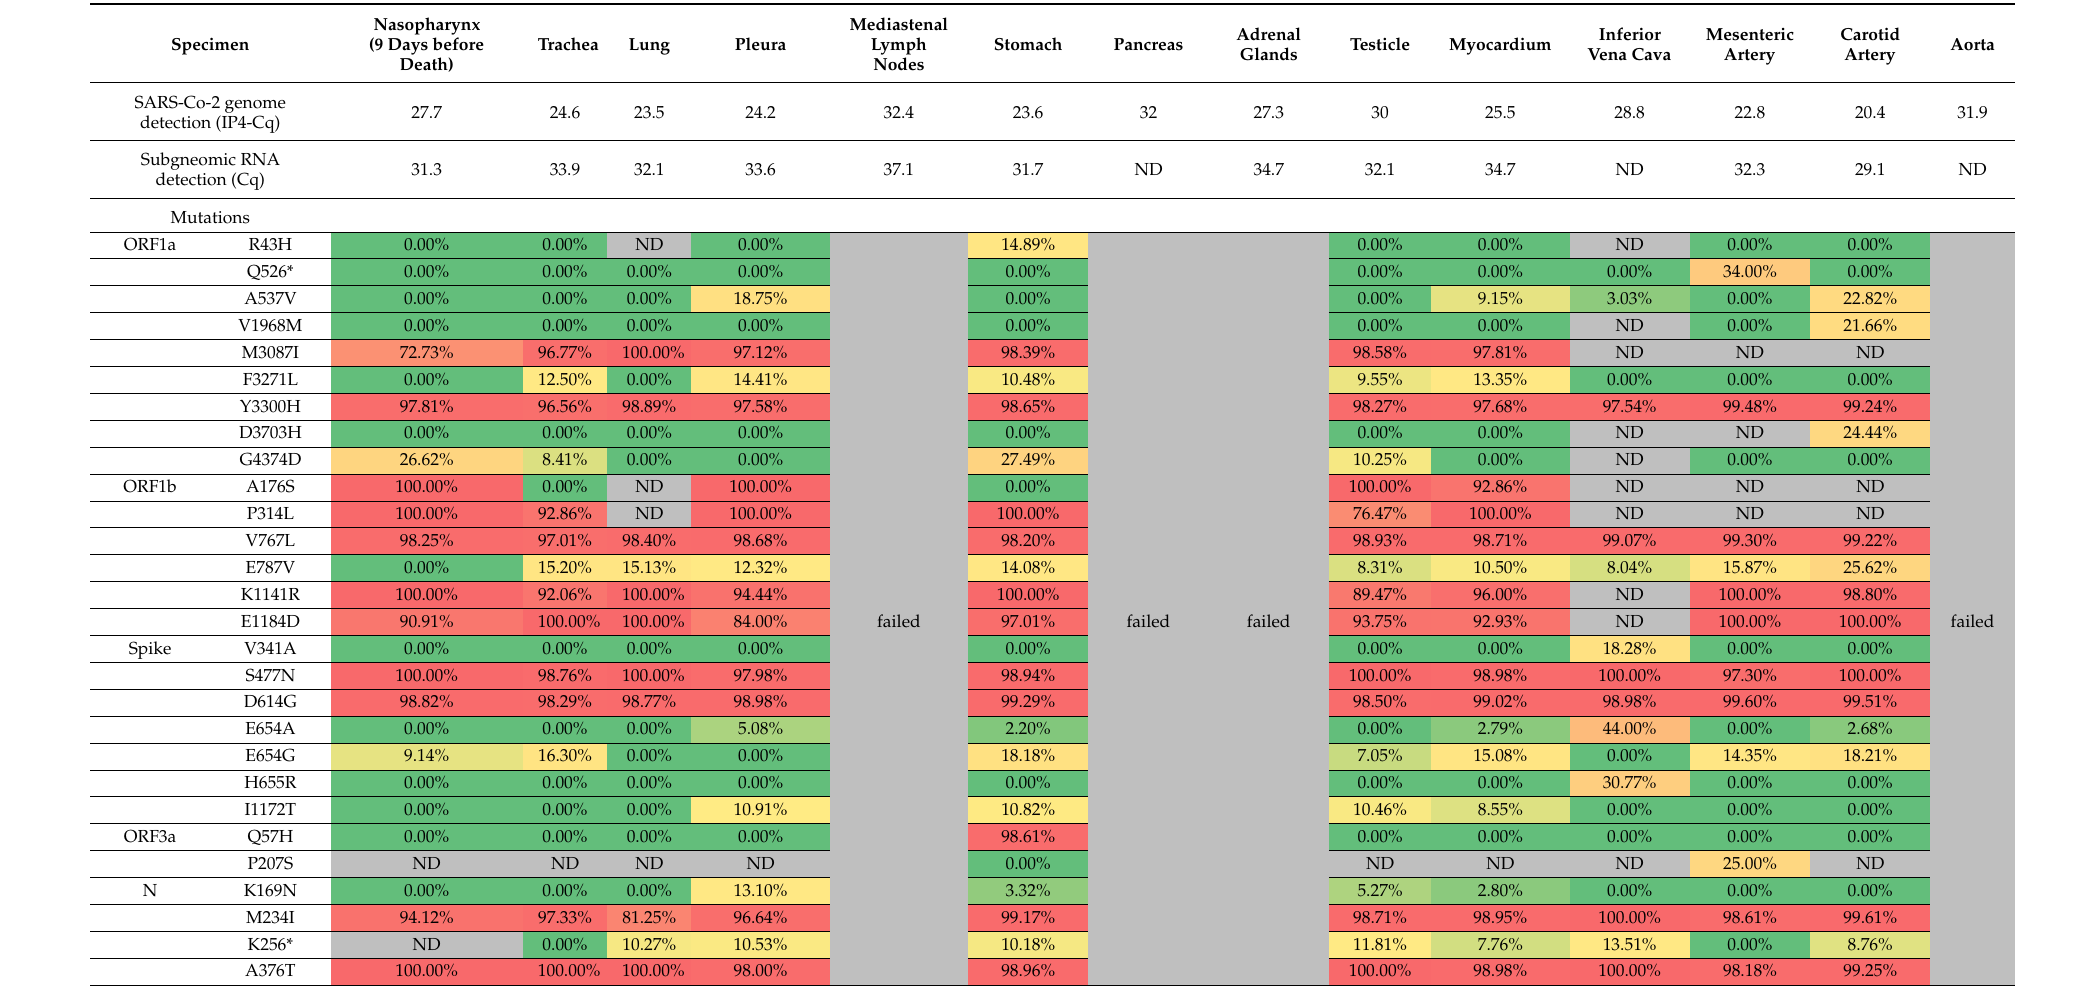
Table 1. Ultra-deep sequencing of SARS-CoV-2 genome isolated from post-mortem biopsies. The gradient color represents the notable proportion of mutations present inside the quasispecies. ND: not